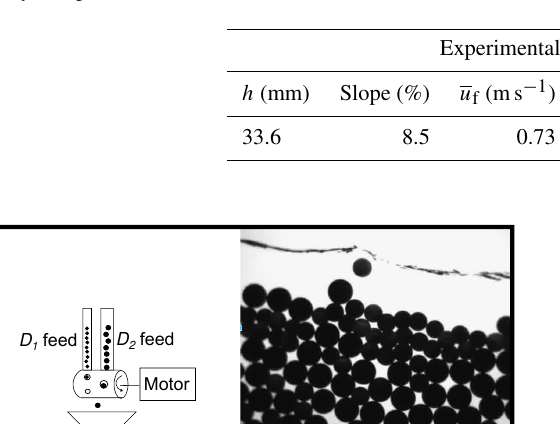
Table 1. Mean flow conditions observed during the experiments. All values are means taken around the range of flow conditions observed over all experiments. h is the mean flow depth, u f is the mean flow velocity, Sh is the Shields number, Fr is the Froude number, Re is the Reynolds number and St is the Stokes number of the large diameter grains. St for the small diameter grains is also much larger than the viscously damped limit.